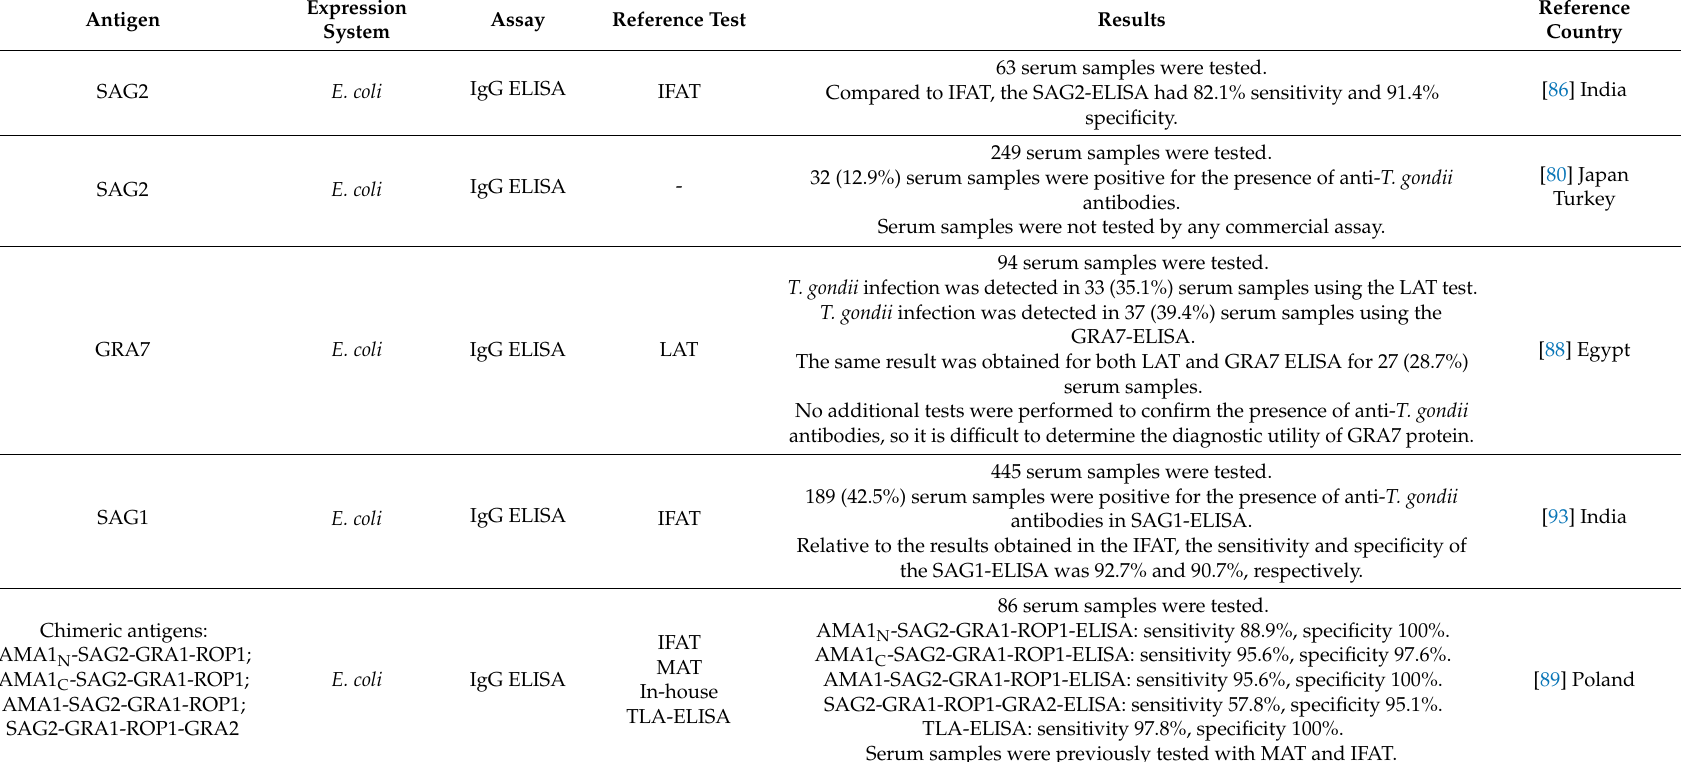
Table 6. Recombinant antigens used in detection of anti -T. gondii antibodies in caprine serum